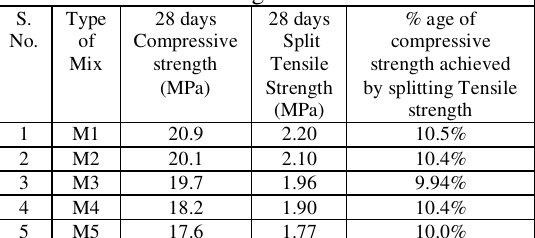
Table 3: Comparison of Compressive and Splitting Tensile Strength Test